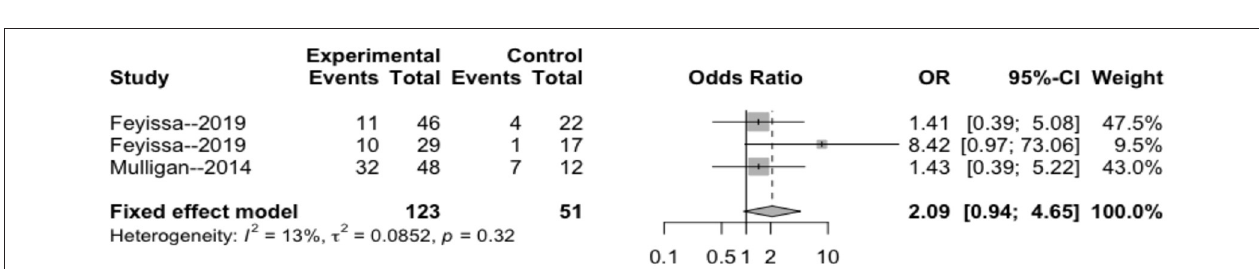
FIGURE 4 | Forest plot of the correlation between 1p/19q deletion and perioperative epilepsy. CI, confidence interval; OR, odds